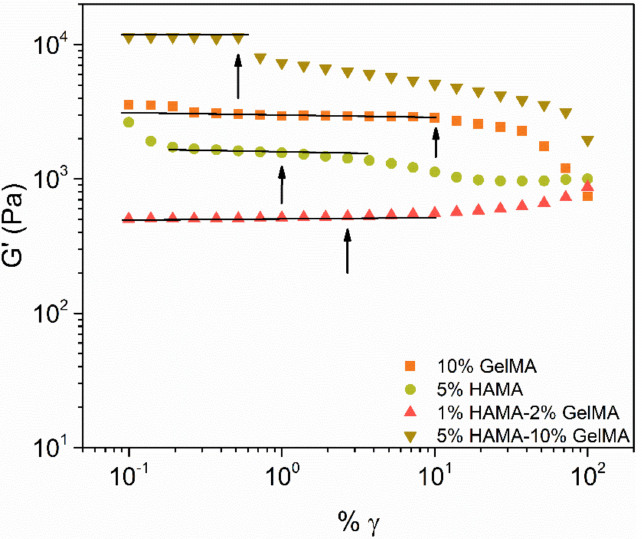
Figure A2. Storage modulus (G’) obtained from oscillatory deformation sweep measured for GelMA, HAMA, and mixtures of HAMA–GelMA at 37 ◦